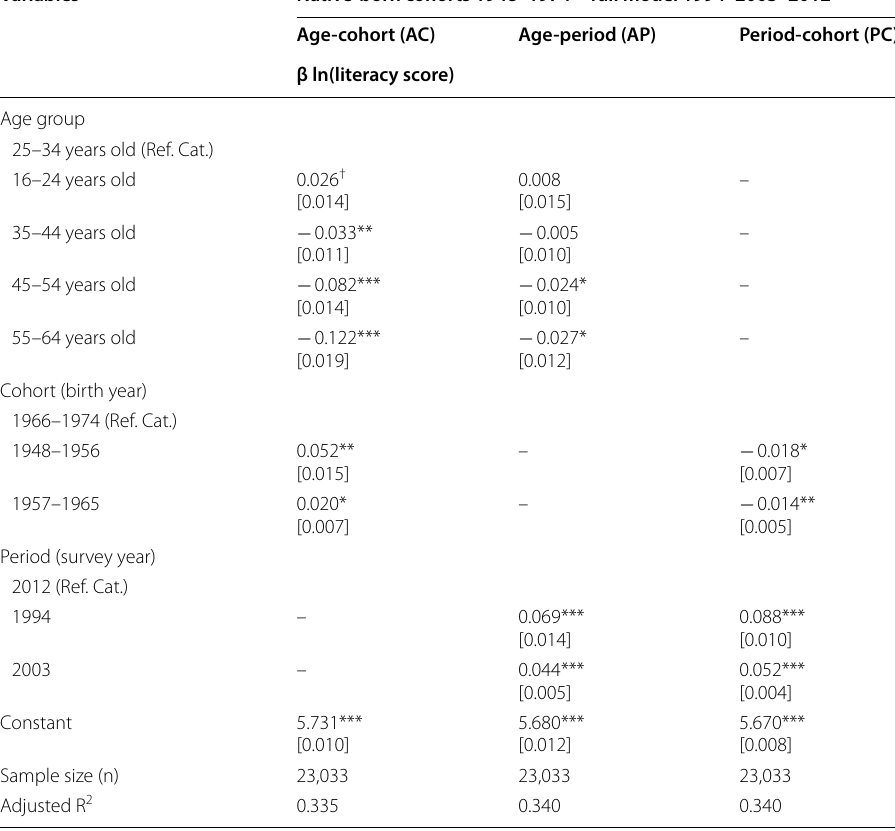
Table 7 Weighted linear regression of the natural logarithm of the literacy score, Canadian-born individuals born between 1948 and 1974, Canada, 1994 IALS, 2003 ALL and 2012 PIAAC data combined (full model—with all control variables and alternating age, period and cohort